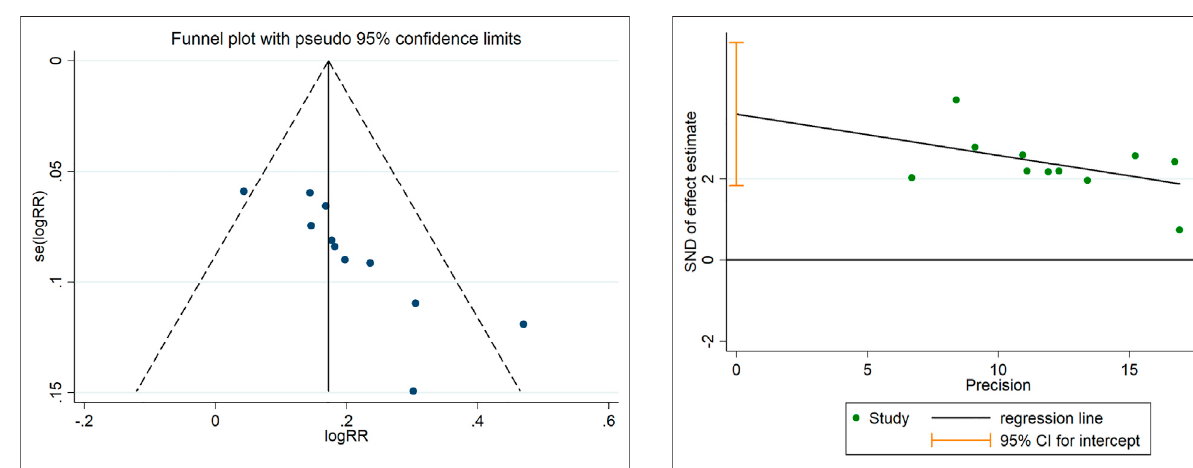
FIGURE 16 | Egger ’ s